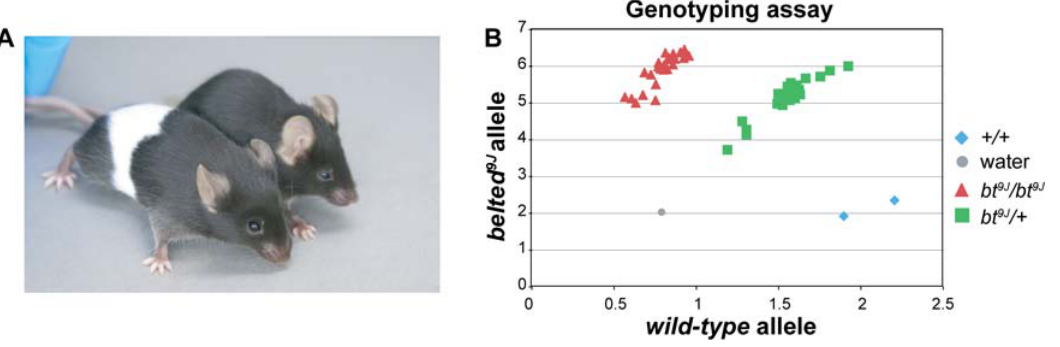
Figure 1. The bt 9J /bt 9J mouse contains a mutation in Adamts20 . (A) An image of a bt 9J /bt 9J mouse (left) and a C57BL/6 mouse (right). (B) A representative result from a genotyping assay for the following genotypes: bt 9J / bt 9J (red triangle), bt 9J / + (green square), wild-type (C57BL/6) (blue diamond), and water control (grey circle).